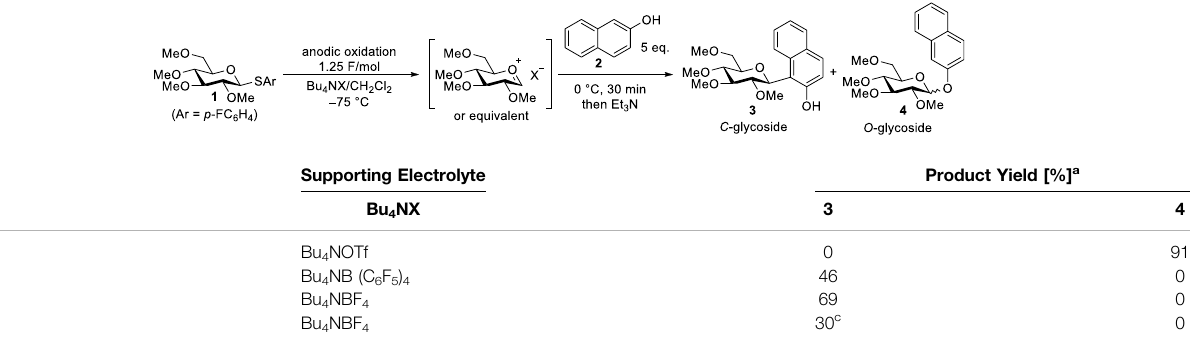
Entry Supporting Electrolyte